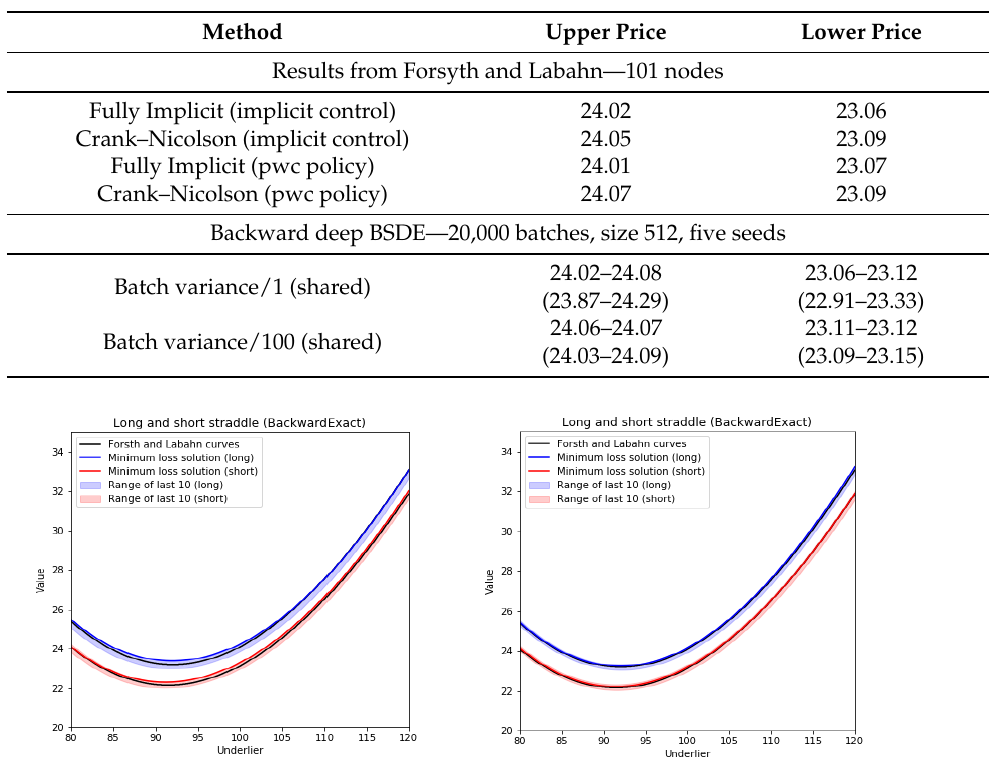
Table 2. Impact of random seed. Fixed X 0 . Exact backward step. Range of price over seeds. Y 0 range over every 100 in the last 1000 in parentheses.